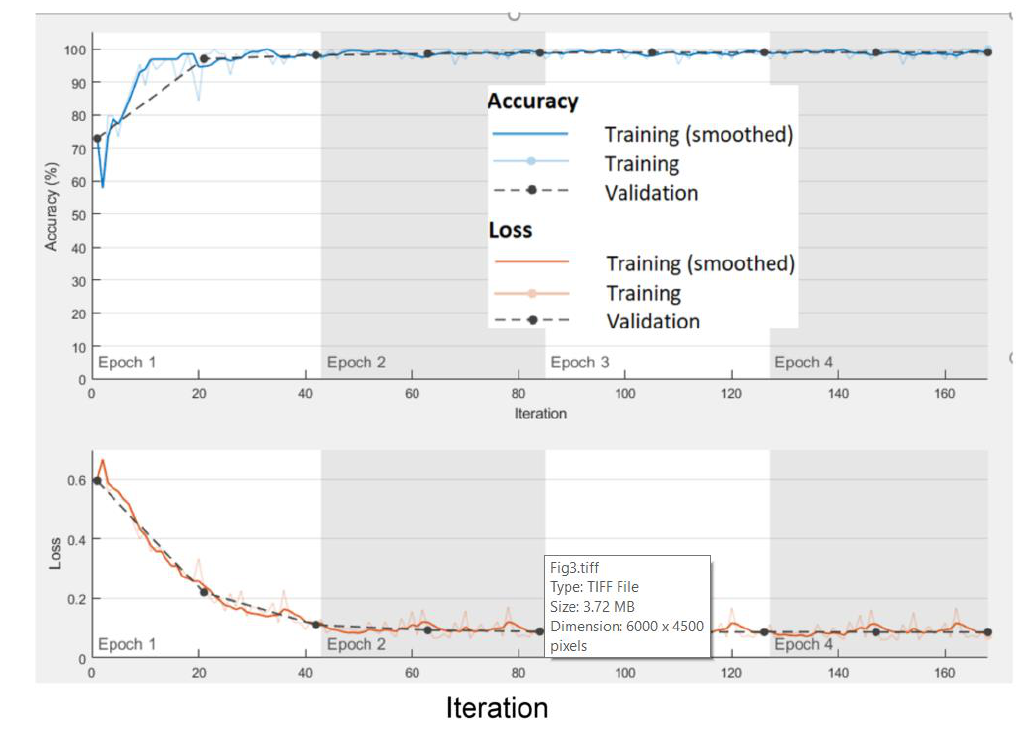
Figure 3. Training progress: training and validation accuracy.